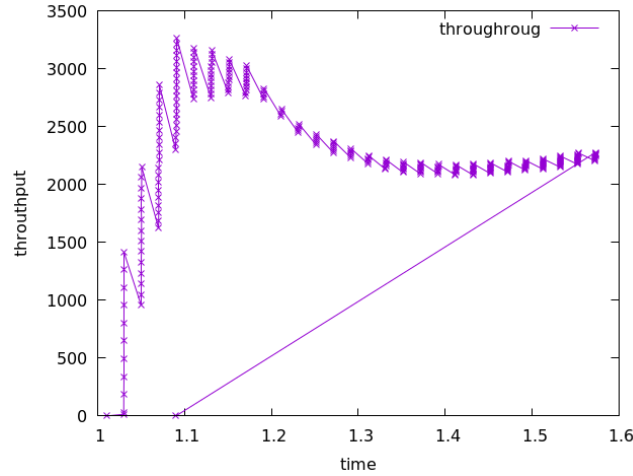
Figure 6. Throughput of traditional network.